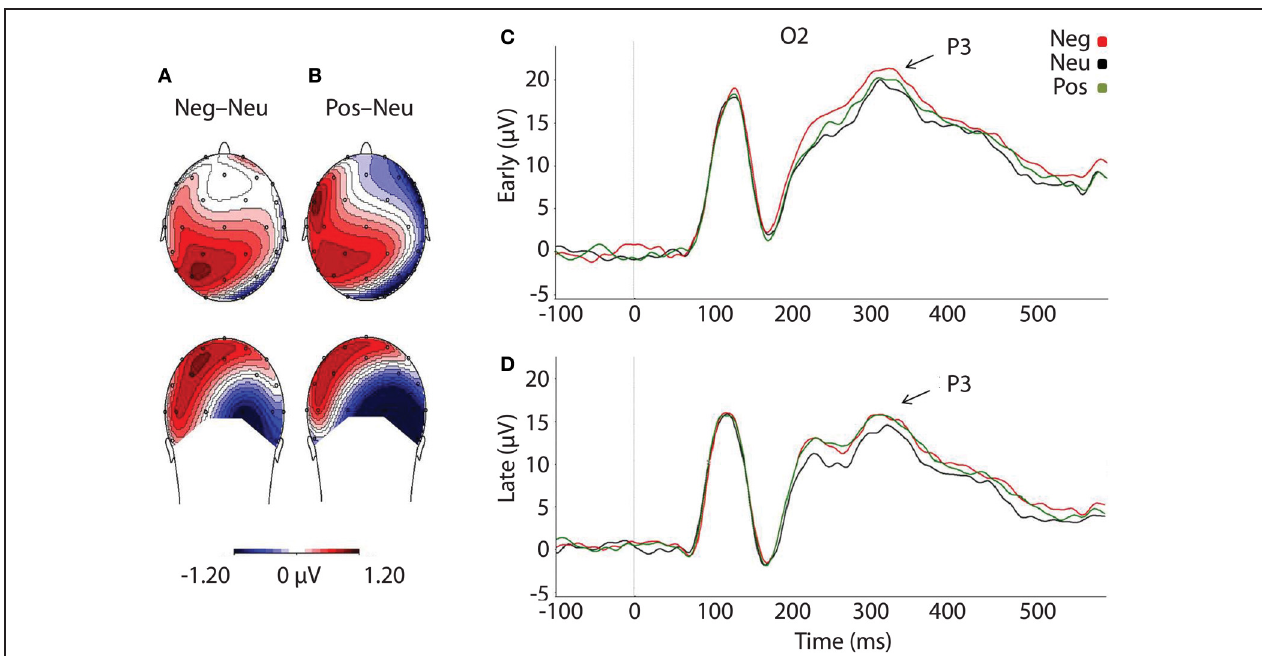
valence by early temporal interval condition (D) Grand-averaged ERP waveforms of subjects during face-targets in each valence by late temporal interval condition. The O2 sensor was selected for representing the P3 component over the right occipital hemisphere, where the P3 was maximal. Neg, Negative; Neu, Neutral; Pos, Positive; µ V, microvolts; ms, milliseconds.